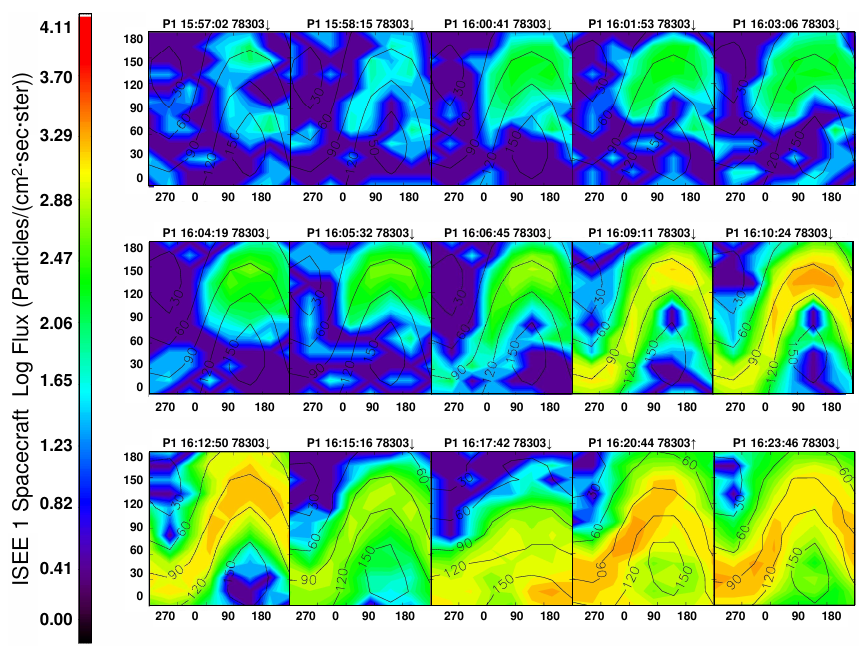
Fig. 3. ISEE-1 MEPE 3-D pitch angle distributions for the time period of 15:57–16:24 UT (Epoch 1 in Fig. 1). The s/c was fully engulfed in CEPs by 16:09 UT, where the particles with a PA of 90 ◦ are seen at all azimuthal angles. The intense population from below the s/c appears around 16:15